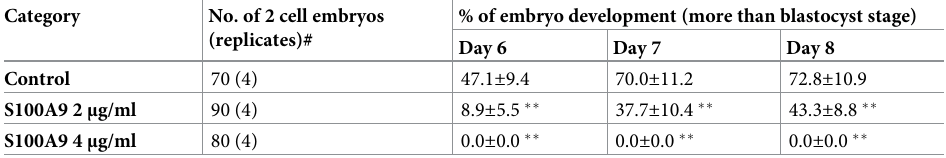
Table 2. Effect of S100A9 on 2 cell stage fertilized embryos. Category